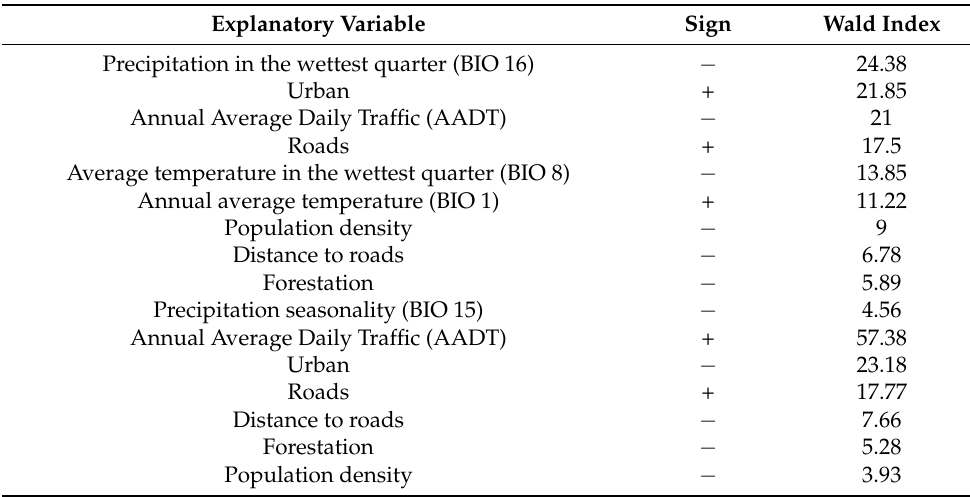
Table 3. Explanatory variables obtained for grassland species. The table on the left corresponds to the complete model, whereas the one on the right corresponds to the anthropic model. Sign: indicates the sign of the variable in the model. Wald Index: indicates the relative importance of each variable in the